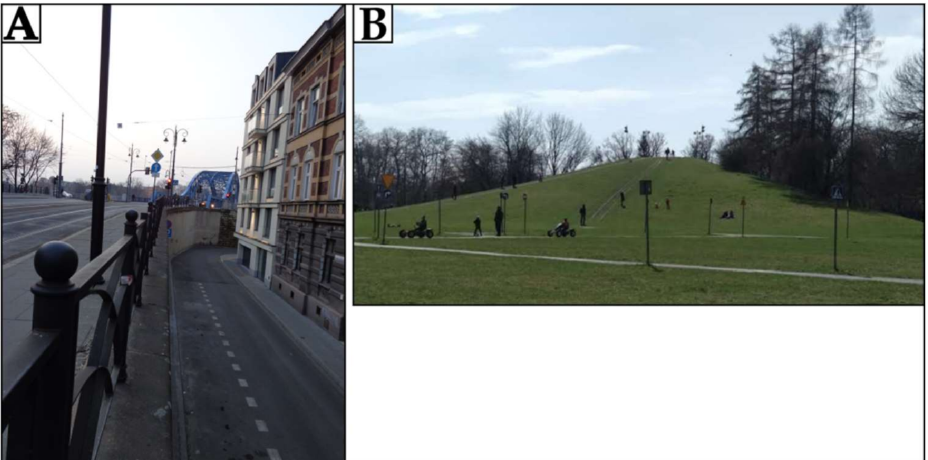
Figure 10. Differentiated thickness of cultural deposits within the Main Market in the Old Town, the creation of which resulted in area flattening. ( A )—view of the eastern part of the Main Market. Location of the selected objects and thickness of cultural deposits in their surroundings: ( B )— Underground Museum, well-visible structure of deposits, ( C )—underground restaurant, former the first floor; ( D )—uncovered fragment of the initial surface at the wall of The Saint Mary’s Church. 2 m thick cultural deposits are marked next to Adam Mickiewicz Monument. March 2021. Photos by R.